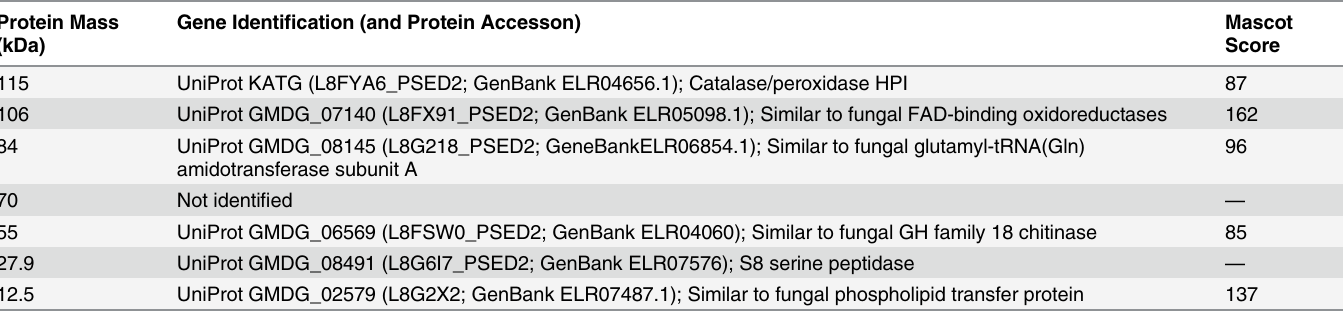
Table 2. Tryptic peptide-mass fi ngerprint analysis by MALDI-TOF MS to identify major P. destructans 1 extracellular proteins resolved by SDS- PAGE. Protein Mass Gene Identi fi cation (and Protein (kDa)